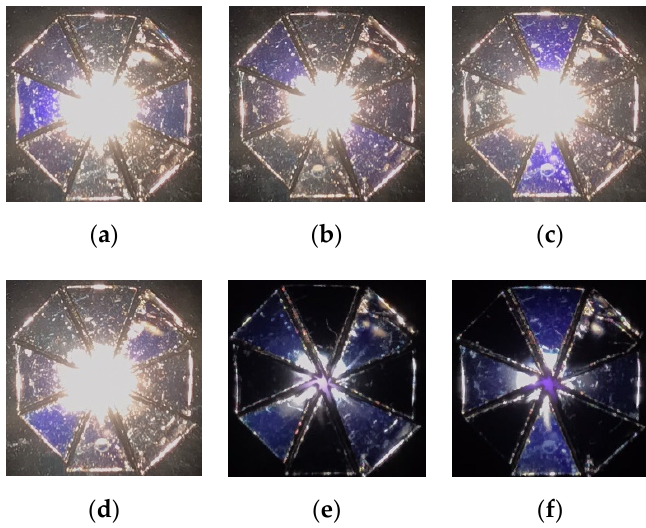
Figure 9. Captured light field distributions with both of the transmitting axes of the polarizer and analyzer set at ( a ) 0 ° , ( b ) 45 ° , ( c ) 90 ° , and ( d ) 135 ° , and with the transmitting axes of the polarizer set at